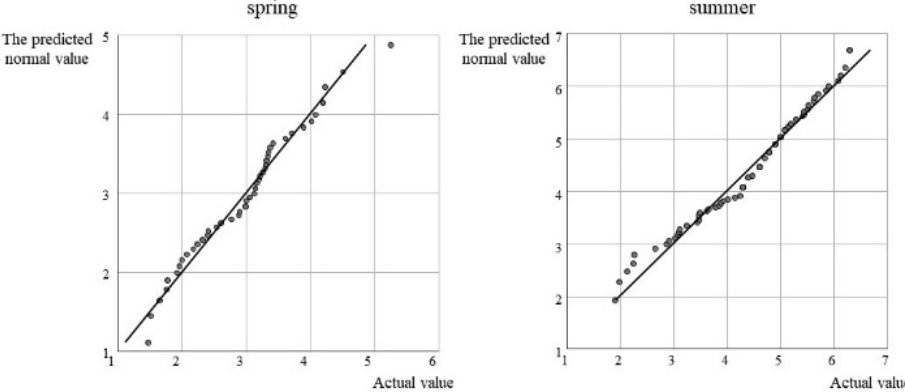
Figure 3. QQ ‐ plot of A. thazard lg (Catch) in spring and summer. Figure 3. QQ-plot of A. thazard lg (Catch) in spring and summer.